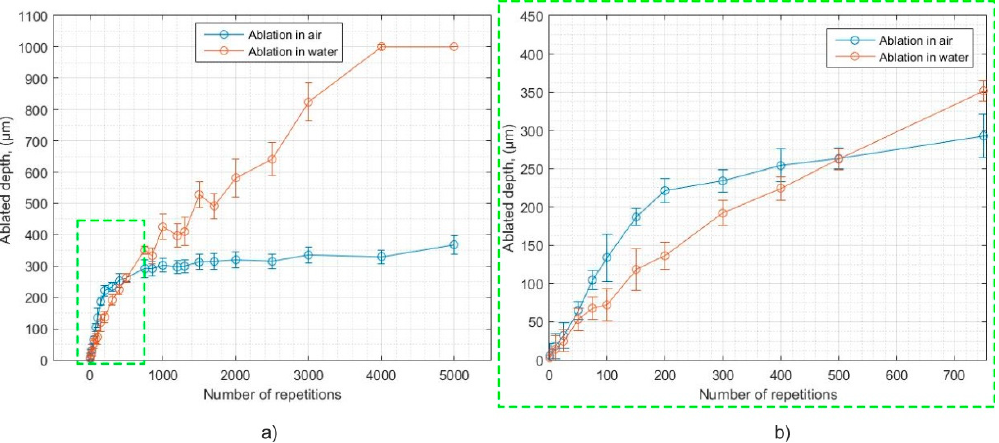
Figure 4. Ablated depth vs. number of repetitions ( a ), for ablation in water and in ambient air. A magnified view from 1 to 700 repetitions is displayed in ( b ).